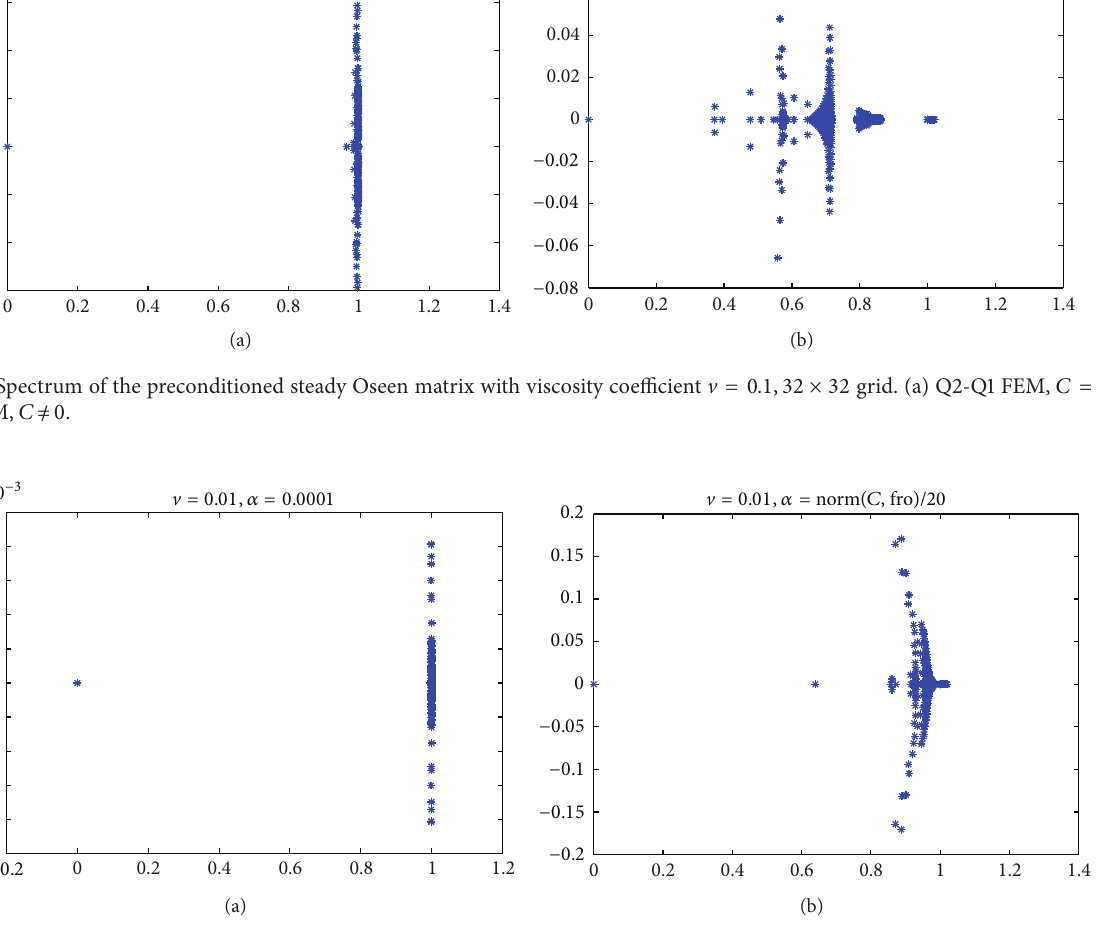
Figure 2: Spectrum of the preconditioned steady Oseen matrix with viscosity coefficient V = 0.01, 32 × 32 grid. (a) Q2-Q1 FEM, 𝐶 = 0 ; (b) Q1-P0 FEM, 𝐶 ̸=0 .